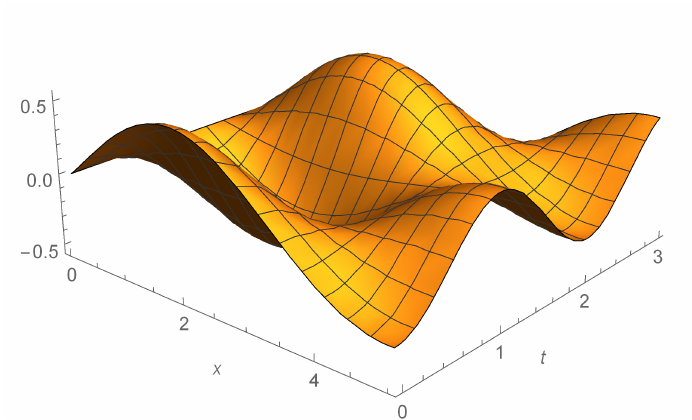
Figure 3. Smooth longitudinal wave (with α = 1 )